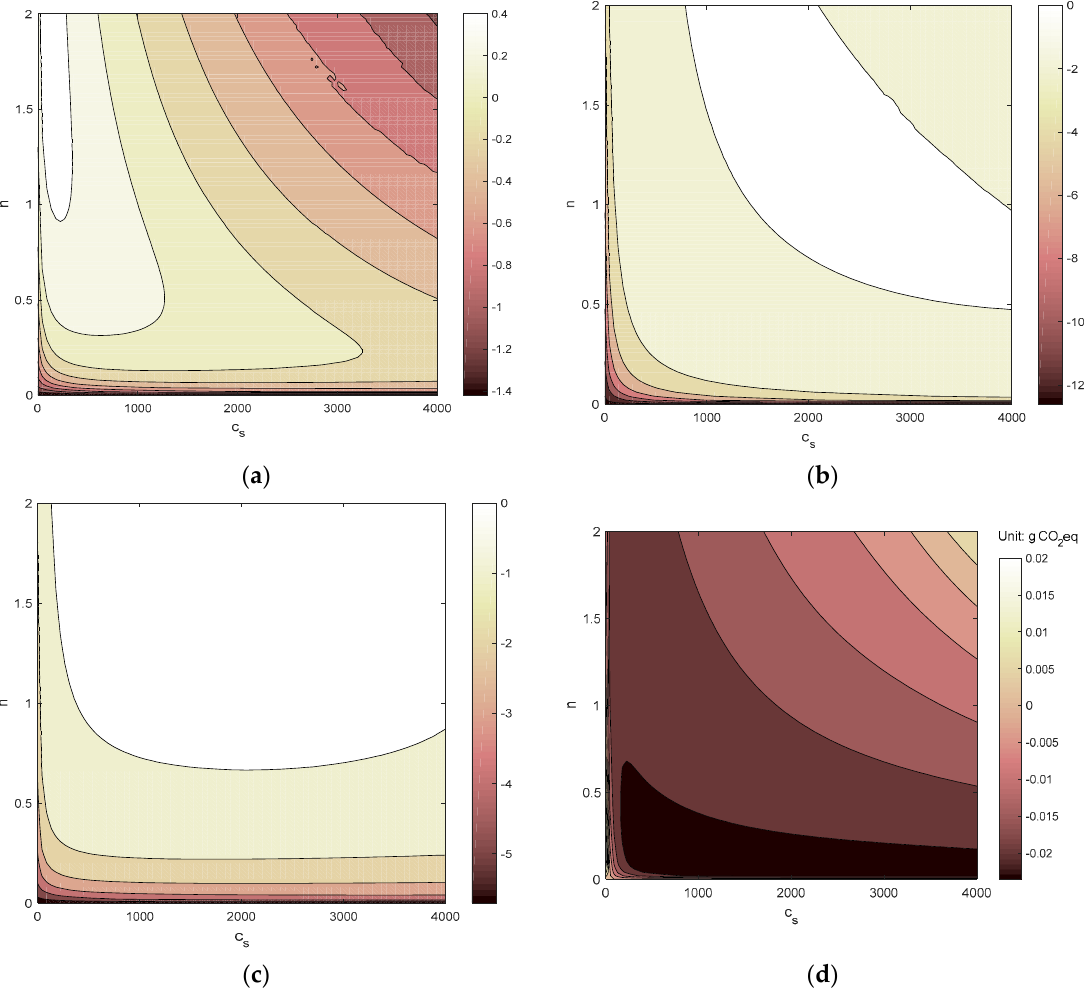
Figure 5. The relations between control parameters and different suspension performance criteria with regenerative suspension compared with passive suspension. ( a ) Vertical acceleration of the vehicle body; ( b ) tyre dynamic load at the front left wheel; ( c ) suspension deflection at the front left wheel; ( d ) WTW GHG emissions of the electricity consumed by regenerative suspension.